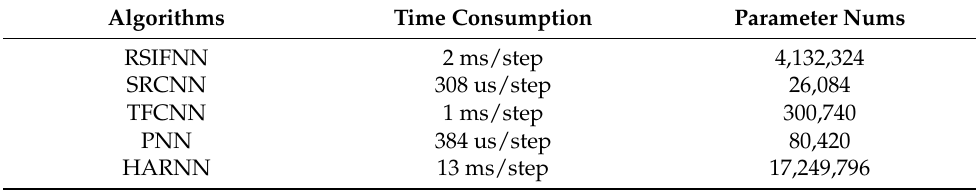
Table 7. The time consumption and the number of training parameters of DL-based methods.